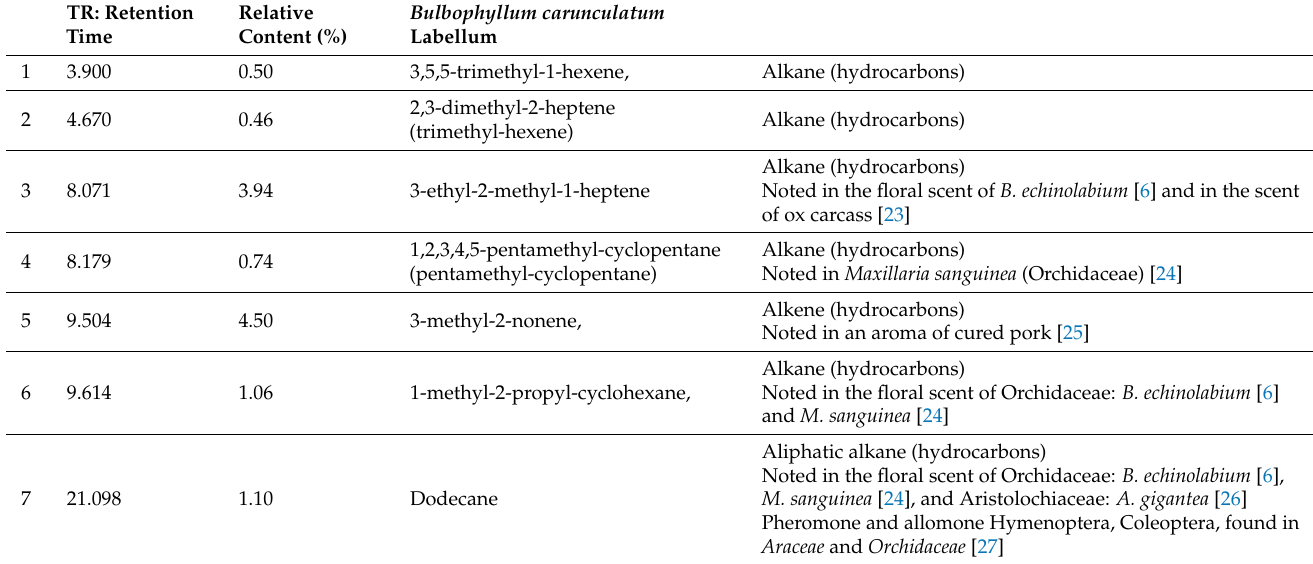
Table 1. Chemical composition of labellum of Bulbophyllum carunculatum (GC/MS analysis, extract from dichloromethane) in the context of properties and occurrence in other